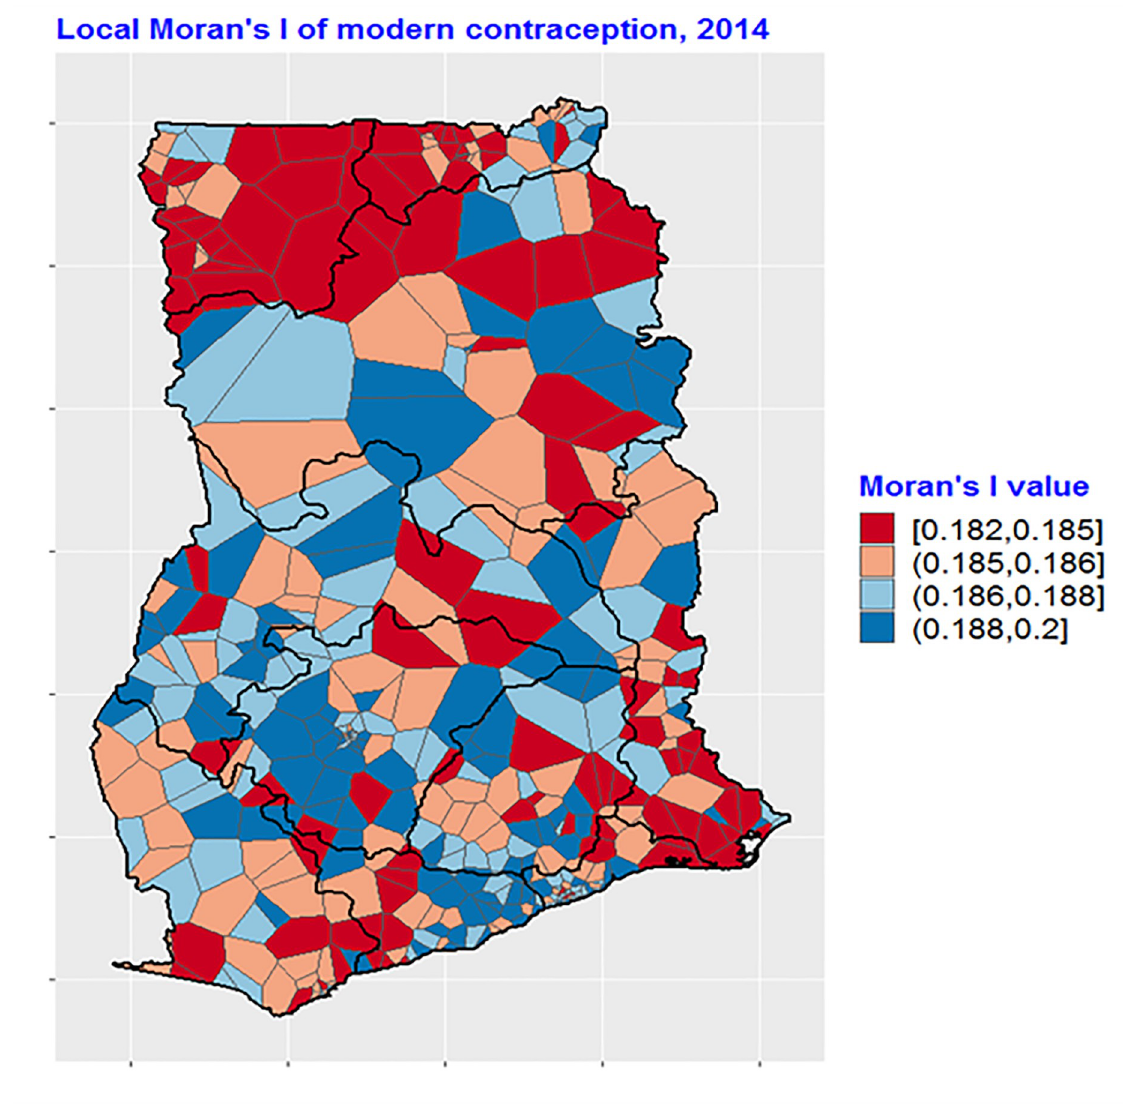
Fig 1. Spatial autocorrelation of modern contraceptive use in Ghana, 2014. Source: Created by the author based on the 2014 GDHS.